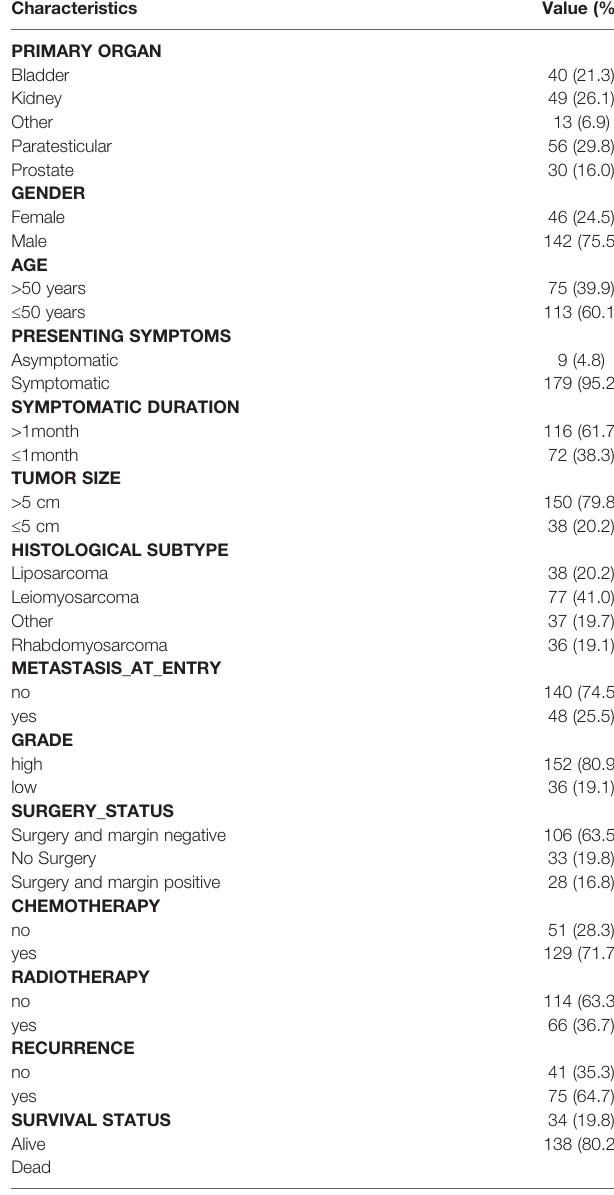
TABLE 1 | Clinical characteristics of patients with genitourinary sarcoma in the present study.